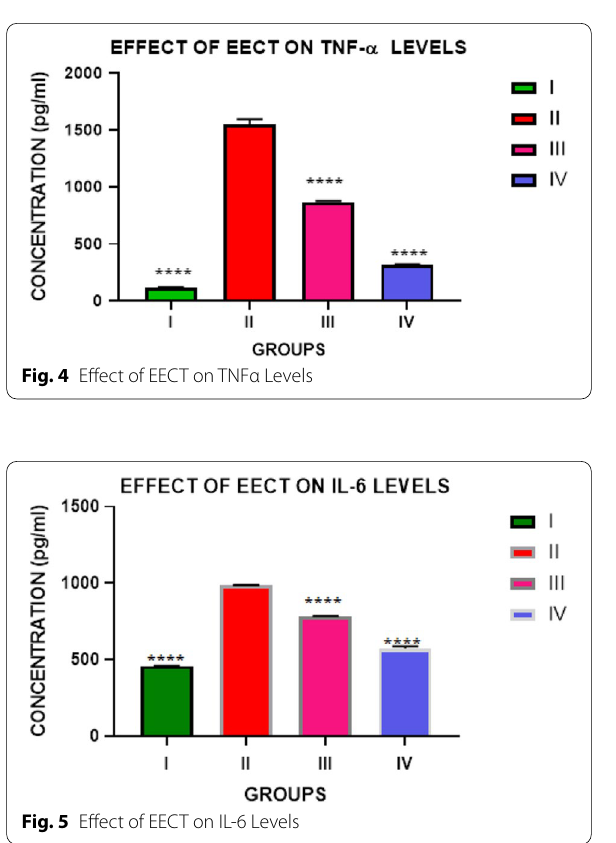
Fig. 8 representing the Caspase 3 expression of various groups.